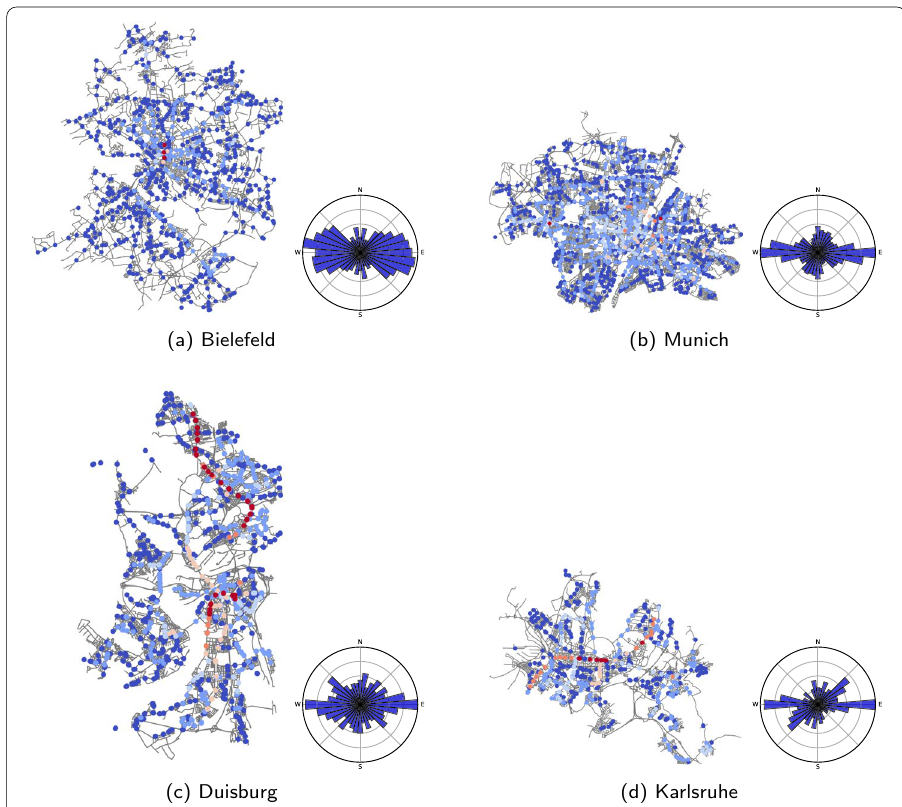
Fig. 14 Comparison of selected German cities’ margial node Katz centralities and public transport orientations. The entries in all supra-adjacency matrices are weighted with travel times and frequencies. The hyper-parameters are chosen as α = 0.5 / (cid:31) max , σ = 5 , and (cid:31) t transfer = 5 for the centrality plots of all cities. The street networks in the background of the centrality plots are created with the OSMnx python package (Boeing